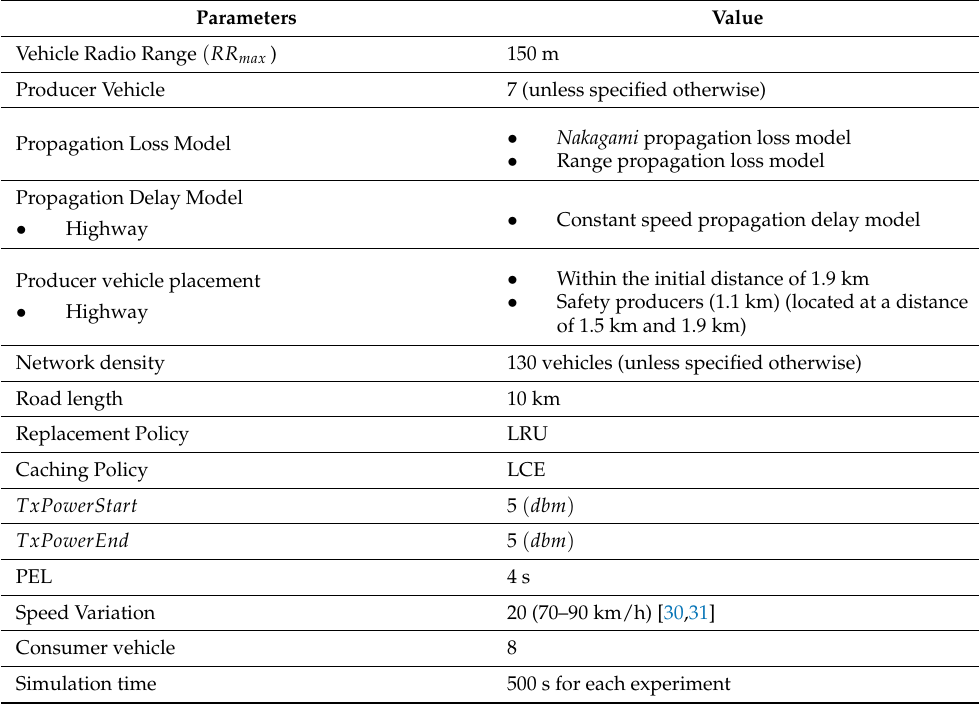
Table 2. Common Configuration